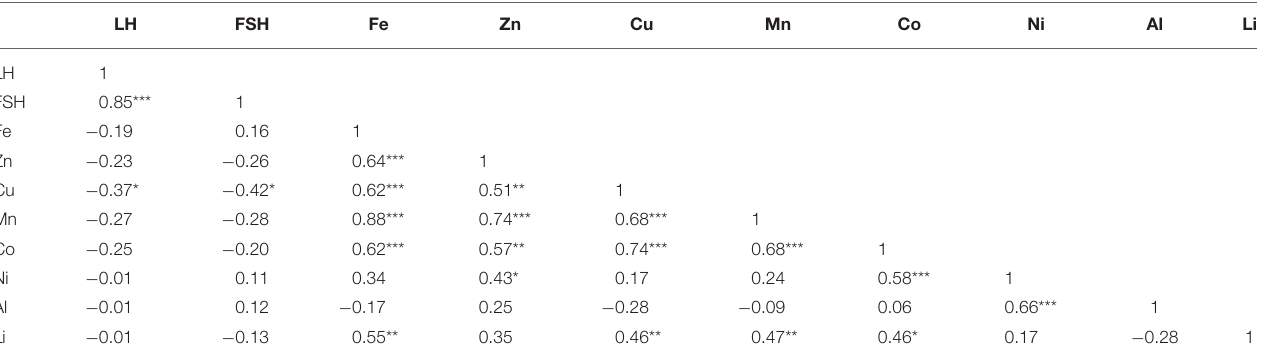
TABLE 2 | Correlation analysis of plasma hormone and brain metal ion